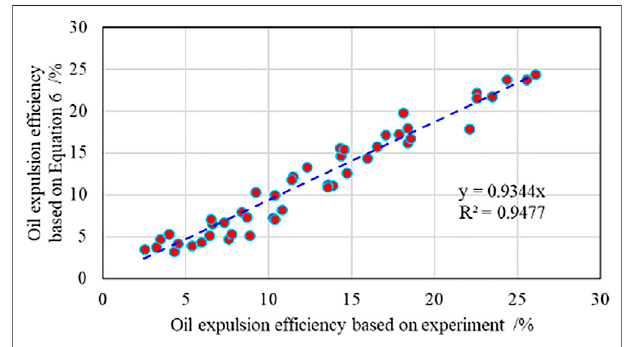
FIGURE 12 | Comparison of oil-expulsion ef fi ciency between experiment and model evaluation.